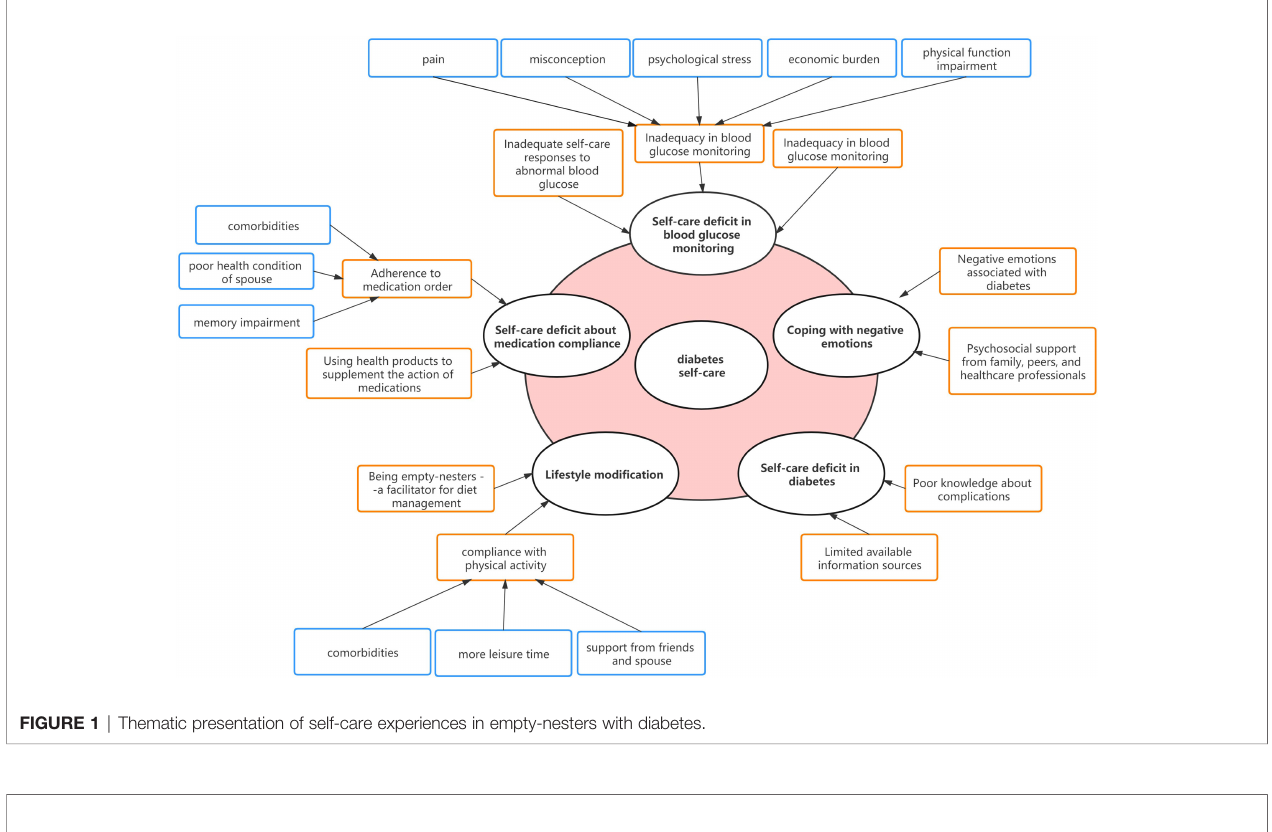
FIGURE 1 | Thematic presentation of self-care experiences in empty-nesters with